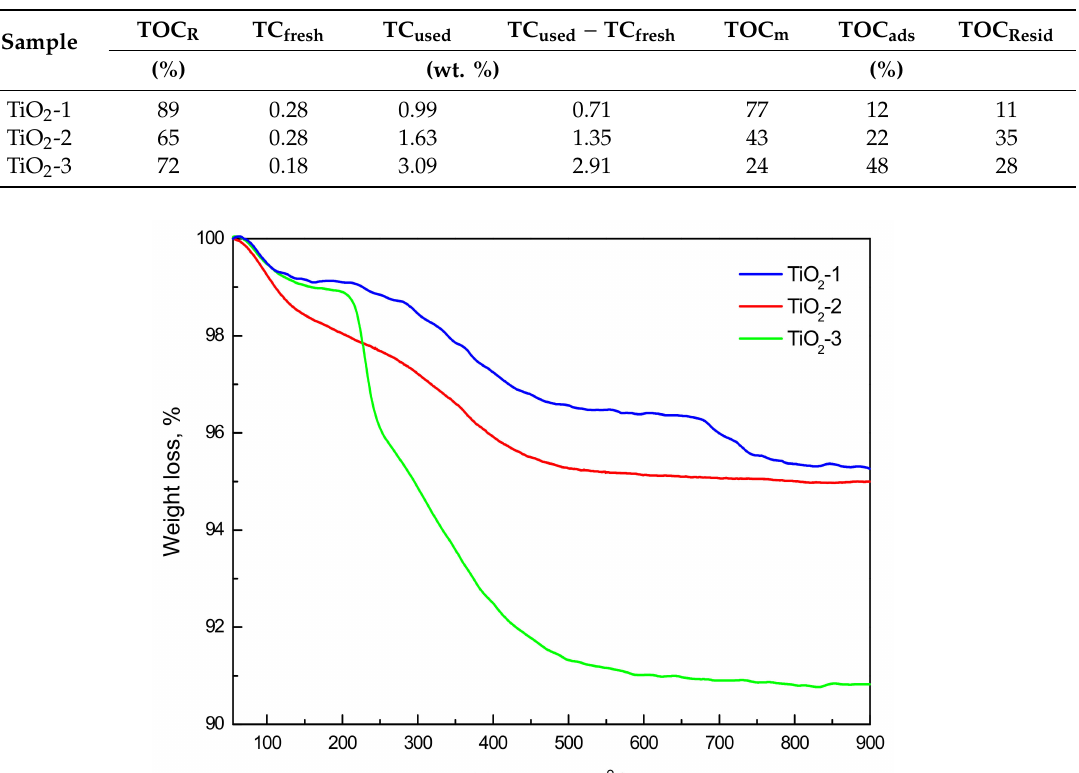
Table 3. Carbon content accumulated on the surface of catalysts before (TC fresh ) and after (TC used ) photocatalytic BPA degradation. TOC removed from the liquid phase (TOC R ) represents a sum of true TOC conversion—mineralization (TOC m ) and TOC accumulation on the catalyst surface as adsorbed and not soluble BPA oxidation intermediates (TOC ads ). TOC content remained in water as soluble BPA oxidation intermediates is designated as TOC Resid .